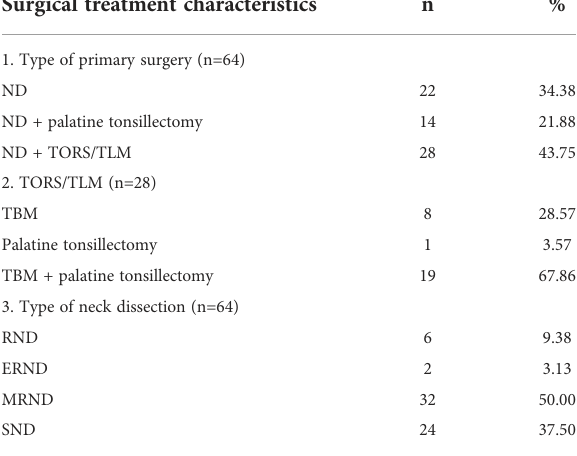
TABLE 3 Surgical treatment characteristics. TABLE 4 Disease relapse and